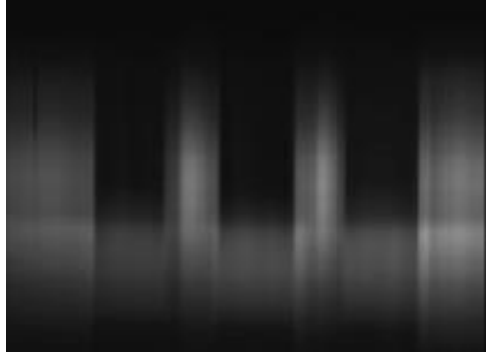
Figure 2. Hyperspectral image of samples of the TF 2012 variety before segmentation and reflectance measurements.